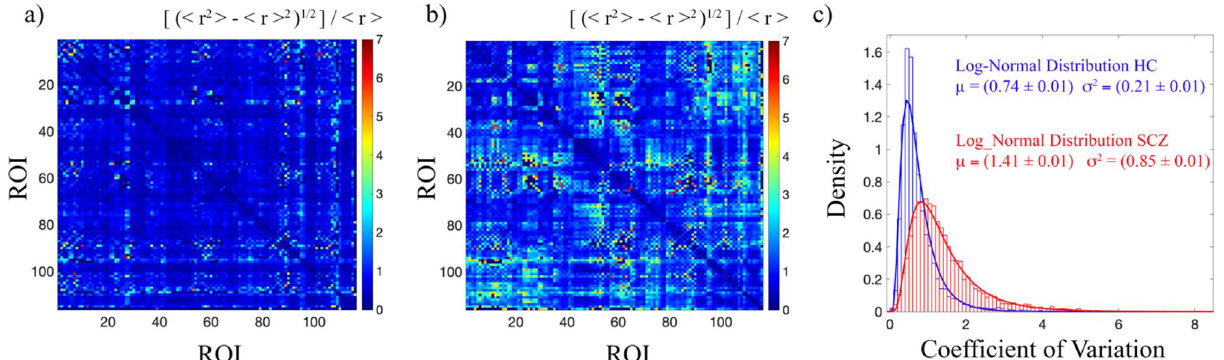
Figure 3. Inter-subjects variability. ( a ) Coefficients of variation matrix for HC, ( b ) coefficients of variation matrix for SCZ, and ( c ) density of the distribution of the pairwise coefficients of variation for HC (blue) and SCZ (red). The coefficient of variation was calculated as the standard deviation ratio to the mean across subjects of the correlation values between each pair of brain areas. Data were fitted to a log-normal distribution with mean μ and variance σ 2 . The curve fitting results are reported for both HC and SCZ with the errors of the fitting procedure. According to a Mann–Whitney–Wilcoxon test, the two distributions resulted significantly different (Z = 57, p < 0.001).